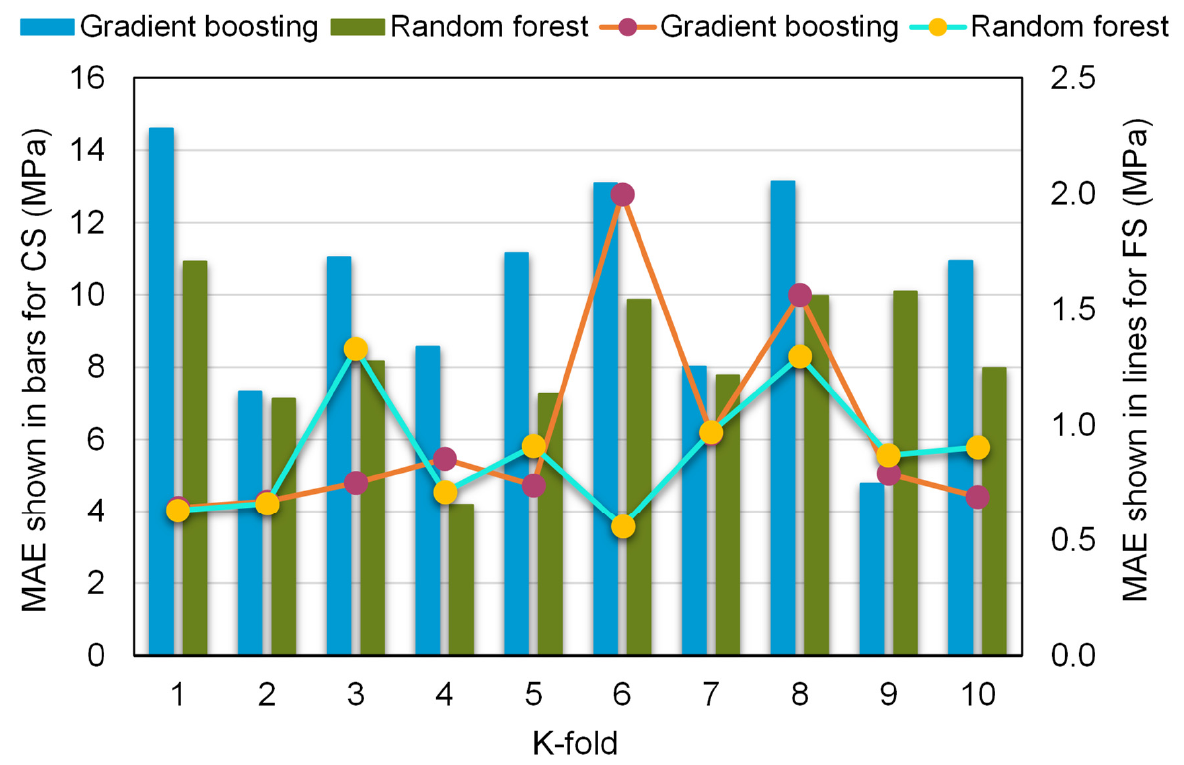
Figure 11. Mean absolute error distribution from k-fold analysis.